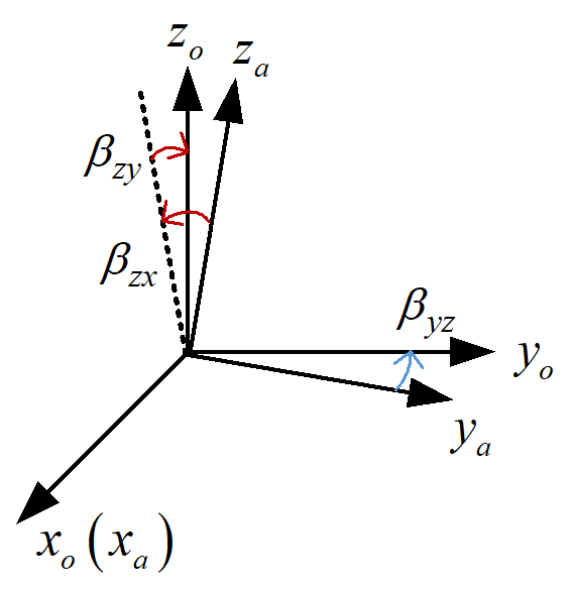
Figure 2. Relationship between accelerometer non-orthogonal coordinate frame and sensitive orthog- onal coordinate